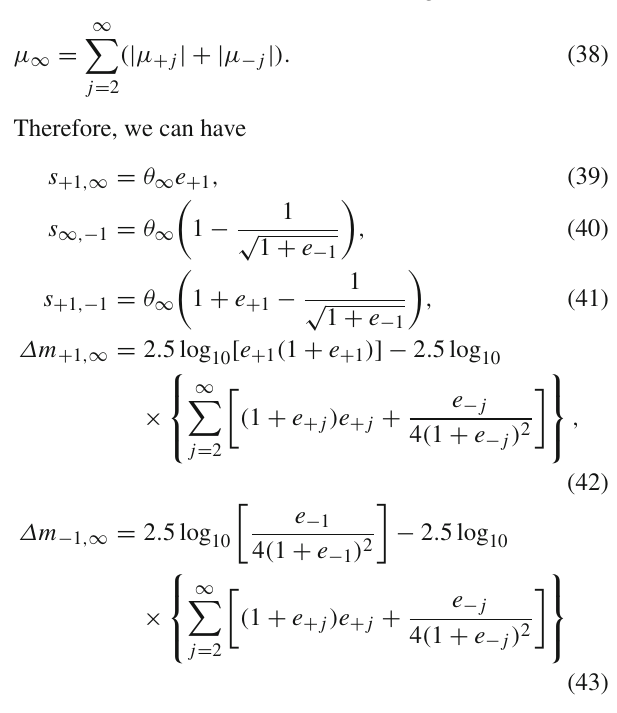
33.0 nas for Sgr A* and 24.7 nas for M87*. However,